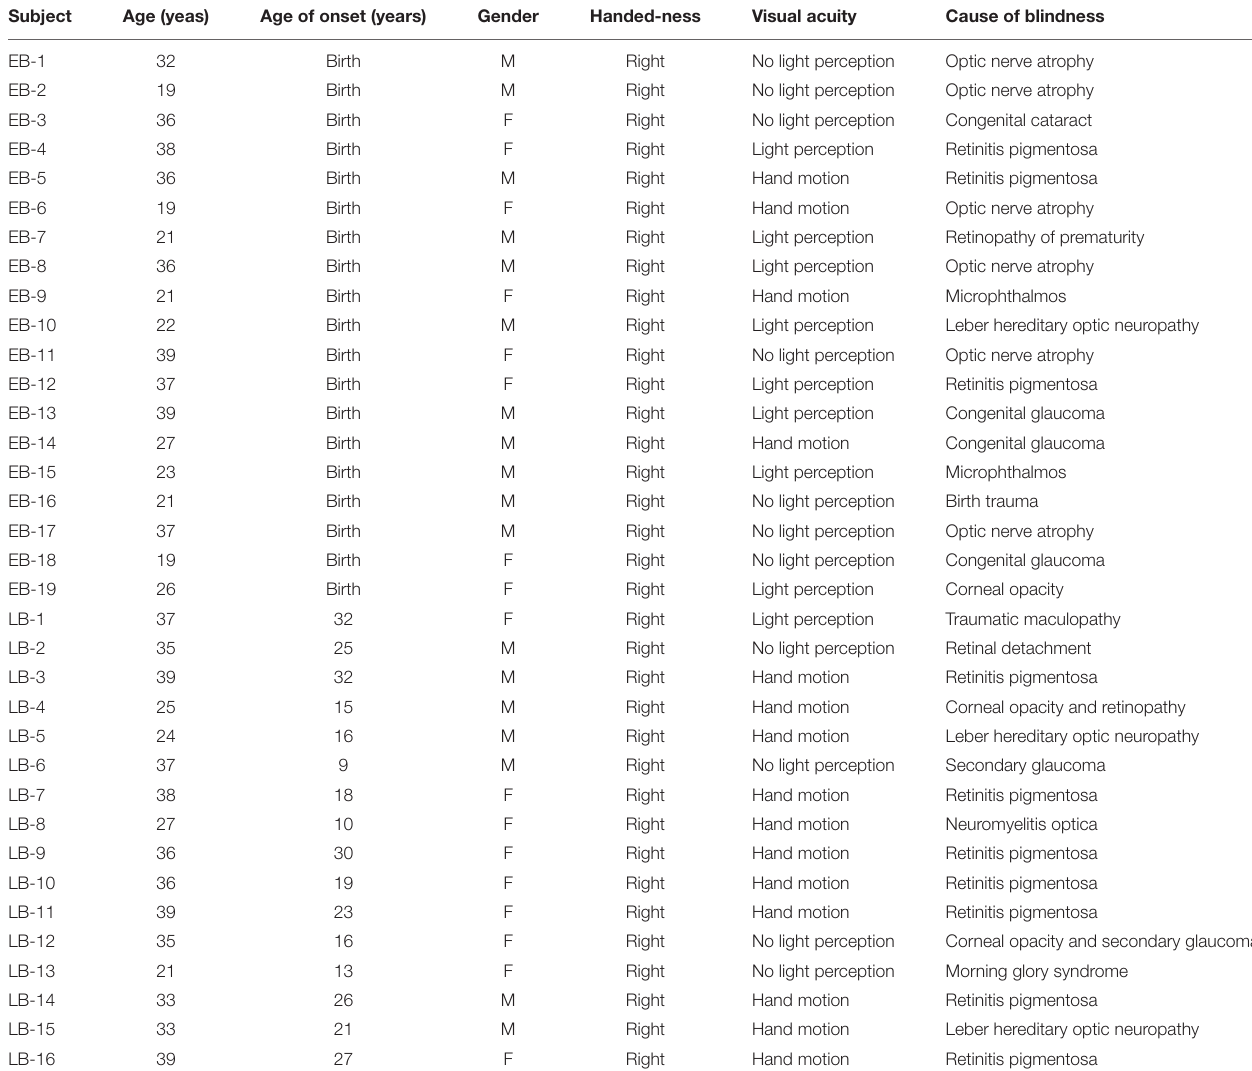
TABLE 2 | Characteristics of blind